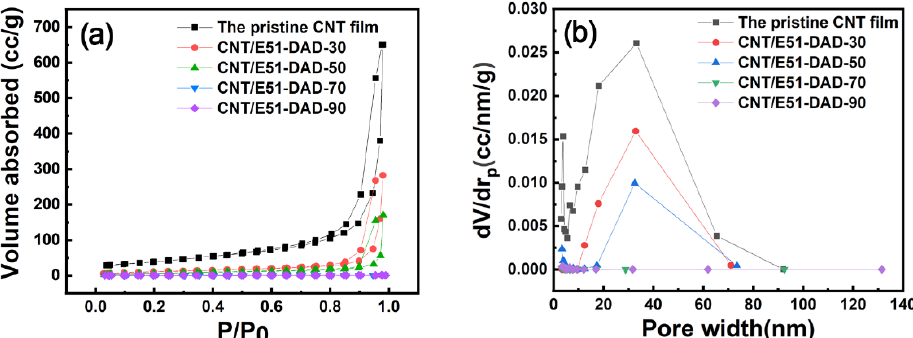
Figure 7. ( a ) N 2 adsorption–desorption isotherm curves and ( b ) pore size distribution curves of the pristine CNT film and CNT composite films after infiltrating the E51-DAD resin. Table 2. The specific surface areas and pore diameters of the pristine CNT film and the CNT composite films after infiltrating the E51-DAD resin .